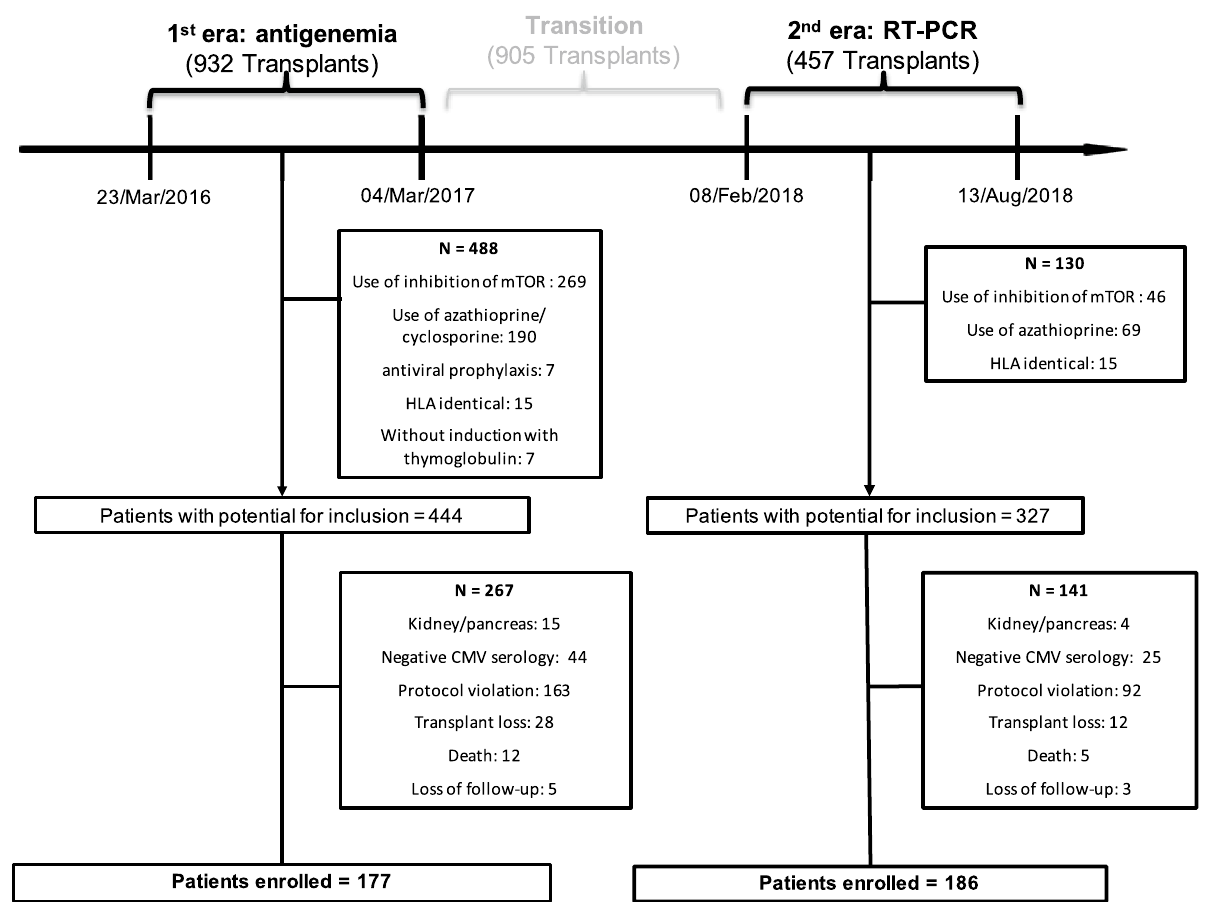
Figure 1. Flowchart of the population. The transition period is from March 2017 to February 2018, when the service had adopted both methods for viremia detection. CMV, cytomegalovirus; HLA, human leukocyte antigen; mTOR, mammalian target of rapamycin; RT-PCR, real-time polymerase chain